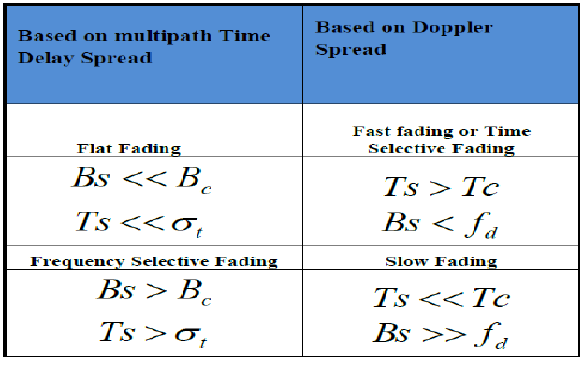
Figure 2: Wireless channel types based on multipath time delay spread and Doppler